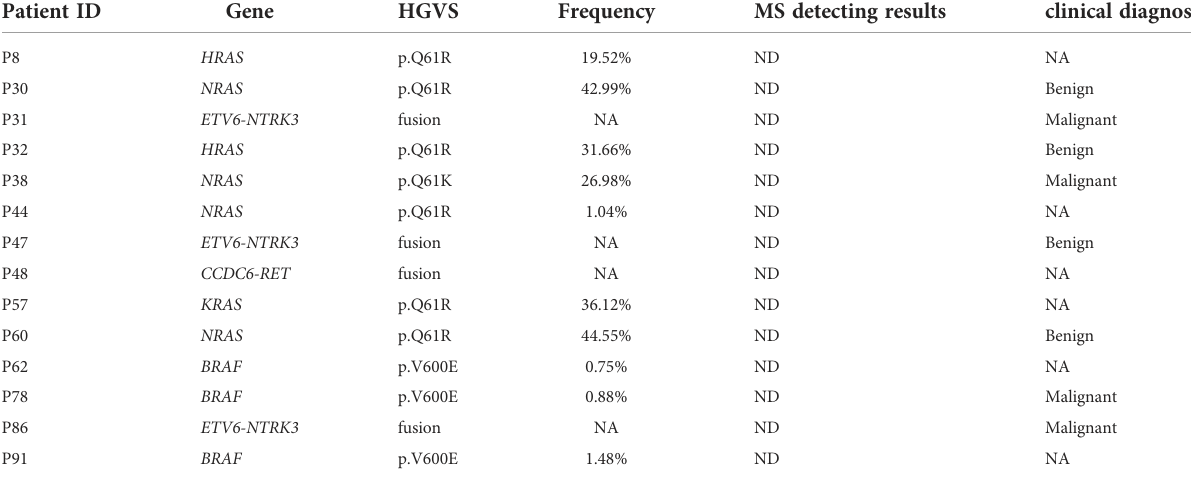
TABLE 2 The gene mutations of patients who was negative in MS detected by NGS.